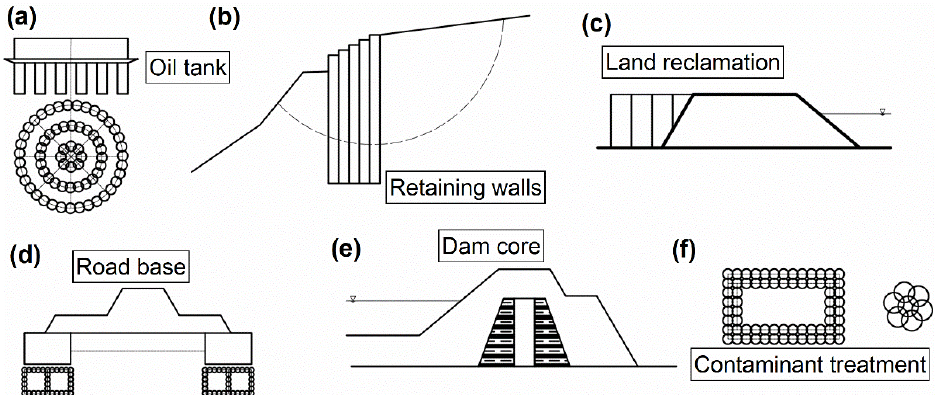
Figure 1. Applications of soil mixing in cold regions: ( a ) oil tanks using DSM as the foundation, ( b ) retaining walls, ( c ) support for land reclamation, ( d ) soil mixing base to mitigate the potential seismic activity, ( e ) dam core to eliminate seepage, and ( f ) contaminant containment with the S/S method (drawings not to scale).